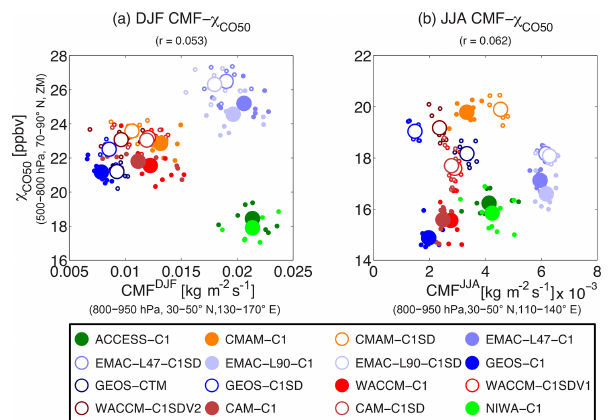
Figure 3. Correlation between Arctic CO50 concentration χ CO50 (units: ppbv) and low-level midlatitude CMF (units: kgm − 2 s − 1 ) in (a) DJF and (b) JJA. Arctic χ CO50 is here the vertical average of 500–800hPa and latitudinal average of 70–90 ◦ N, and zonal mean (ZM). CMF is here the vertical average of 800–950hPa, latitudinal average of 30–50 ◦ N in both DJF and JJA, while the longitudinal average window differs between seasons, as DJF CMF highlights the robust convection over the western Pacific Ocean (130–170 ◦ E) whereas JJA CMF focuses on the maritime convection over East Asia (110–140 ◦ E) following Orbe et al. (2018). Large marks denote the 2000–2009 climatology (except GEOS-C1 and GEOS-C1SD) while small marks denote the corresponding interannual variations in each simulation. Results for C1 simulations are shown as filled circles while C1SD simulations are denoted by open circles. Re- sults of the Pearson correlation coefficients based on climatological means are given in parentheses in the titles. If this correlation co- efficient is significant (95%), a corresponding linear regression is derived using the total least-square method (Petráš and Bednárová, 2010).